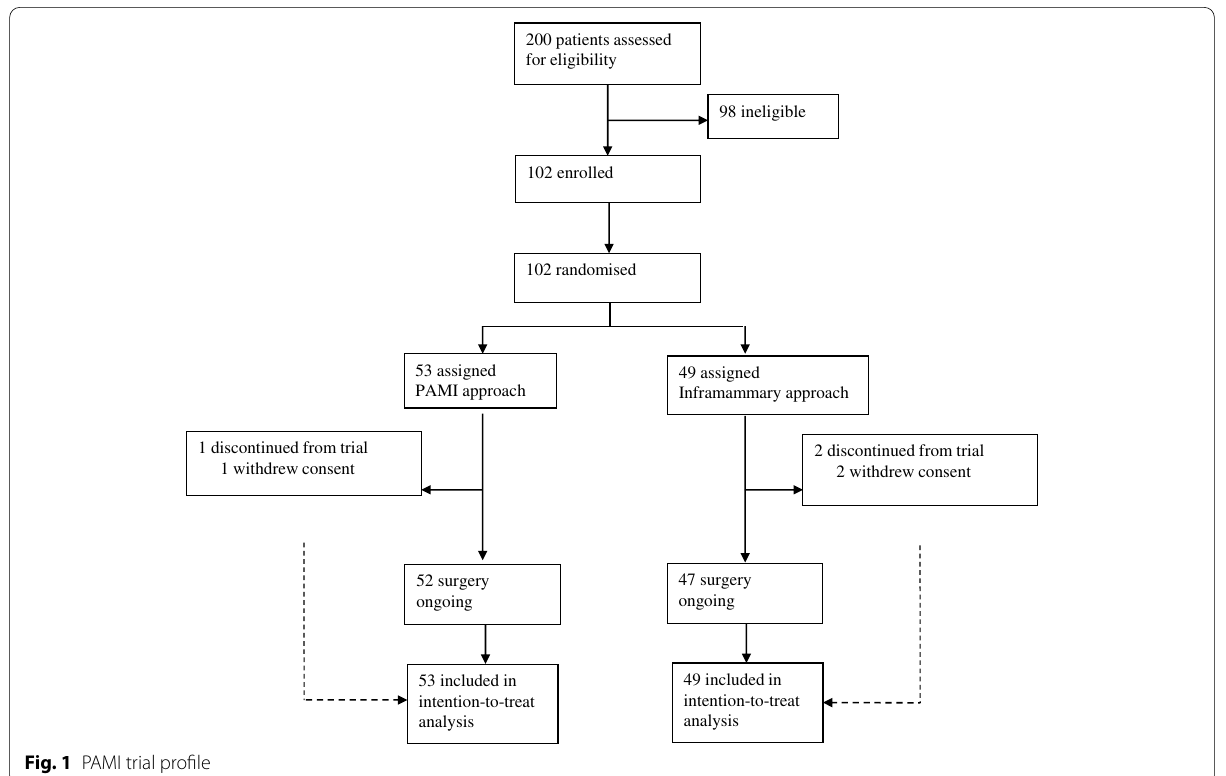
Fig. 1 PAMI trial profile